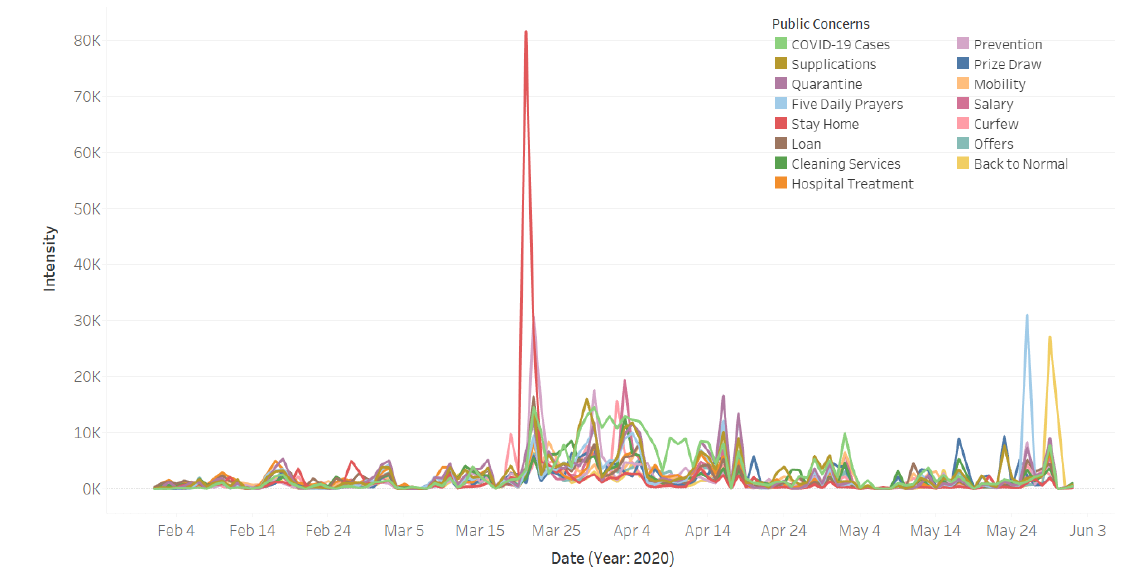
Figure 6. Daily Twitter activity of government measures and public concerns (all).